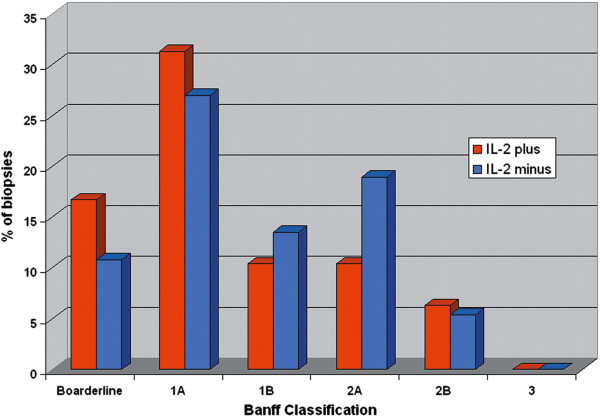
Banff scores of transplant biopsies performed on clinically suspect acute rejection episodes.